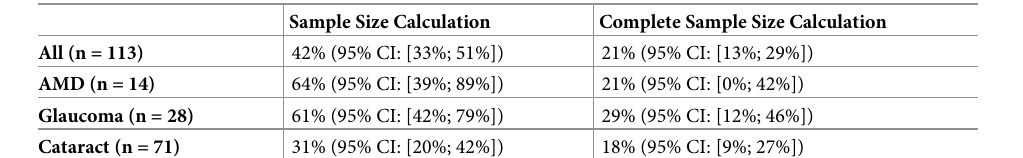
Table 5. Frequency of sample size